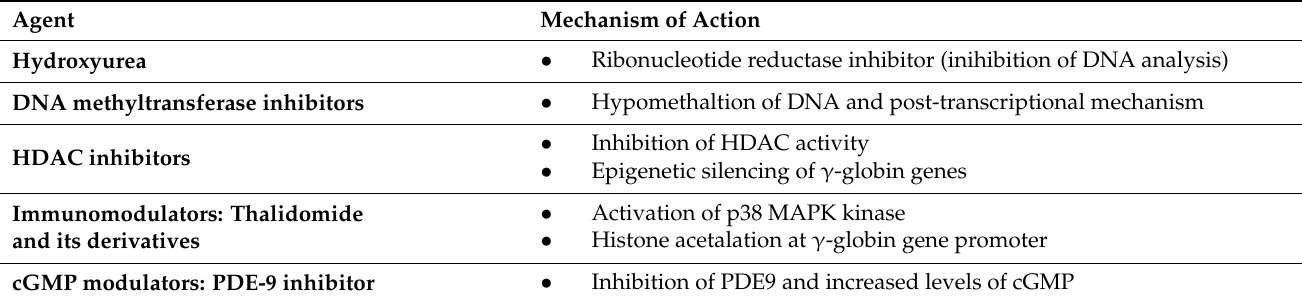
Table 1. Mechanism of action of established pharmacologic approaches to HbF